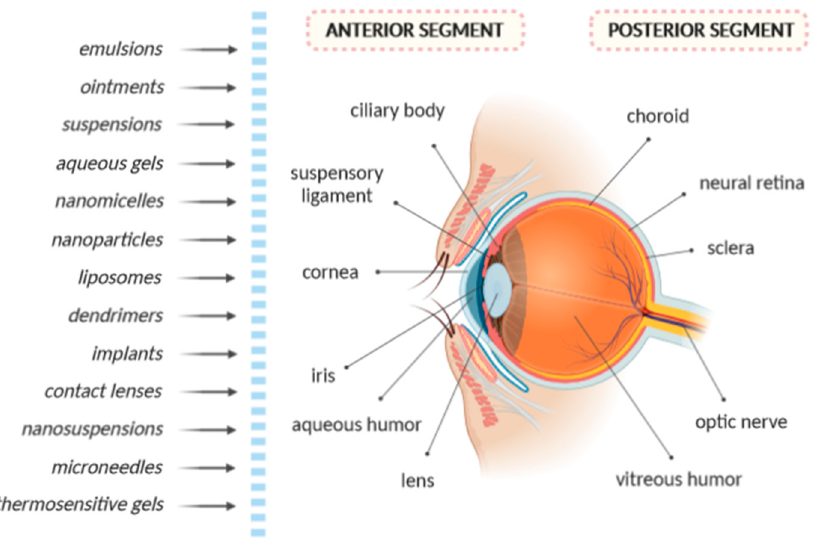
Figure 1. Structure of the human eye and various form of drug delivery systems.